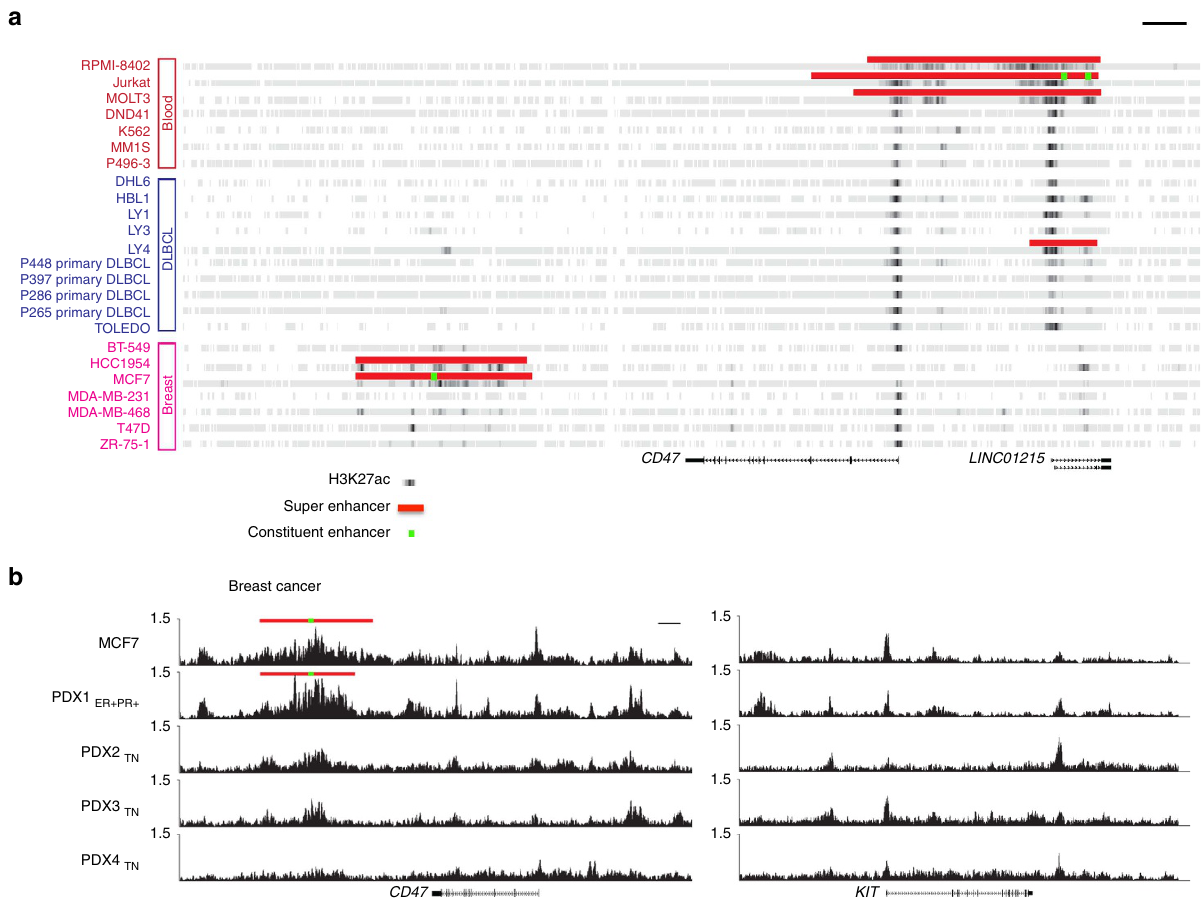
Figure 1 | H3K27ac ChIP-Seq profiling reveals upstream and downstream CD47 super-enhancers. ( a ) Heat map representing H3K27ac enrichment (grey to dark grey) across different cancer lines shows that T-ALL lines (RPMI-8402, Jurkat and MOLT3), the DLBCL line, LY4 and breast cancer lines (HCC1954 and MCF7) have SEs (red lines on top) associated with CD47 . Green blocks: represent functional E5, E3.2 and E7 constituent enhancers from left to right respectively. ( b ) H3K27ac enrichment ( y axis) shows that a downstream SE (red line on top) is associated with CD47 in an ER þ PR þ breast tumour sample (PDX1). Three other triple negative (TN ¼ PR (cid:2) , ER (cid:2) and Her2 (cid:2) ) breast tumour samples (PDX2-4) shown H3k27ac enrichment in the CD47 locus, but these genomic regions do not qualify as SEs. Right panel: H3K27ac ChIP-Seq binding profiles show typical enhancers at the KIT gene for size comparison between SEs and typical enhancers. Green blocks: represents the functional E5 constituent enhancer. Scale